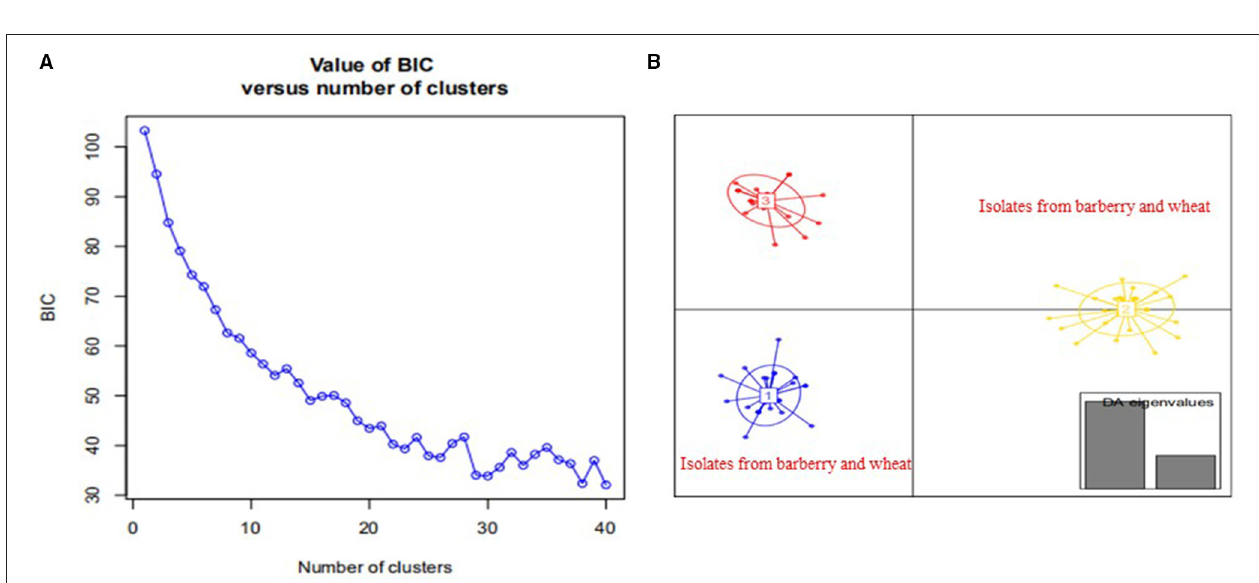
FIGURE 7 | Clustering of 83 P. striiformis f. sp. tritici isolates from barberry bushes and wheat plants in field to genotypic groups for the optimal K -value ( K = 3). (A) Values of logarithm likelihood based on analysis by structure program. (B) Each of color bars represents a kind of genotypic group.